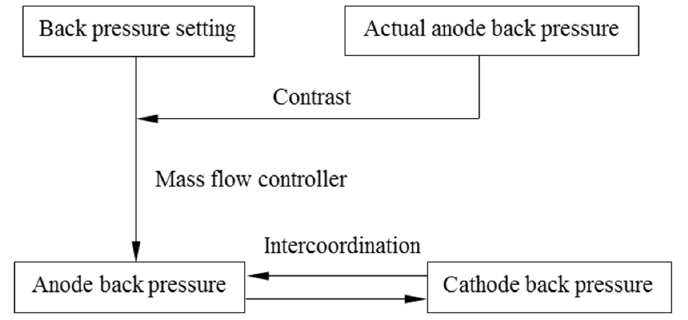
Figure 5. Flow chart of the back pressure control module.